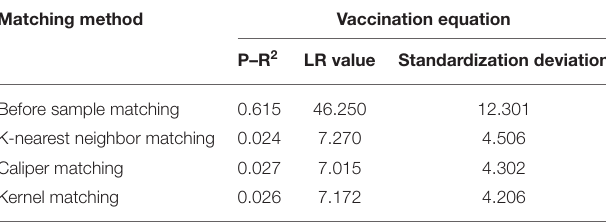
TABLE 4 | Results of balance test.